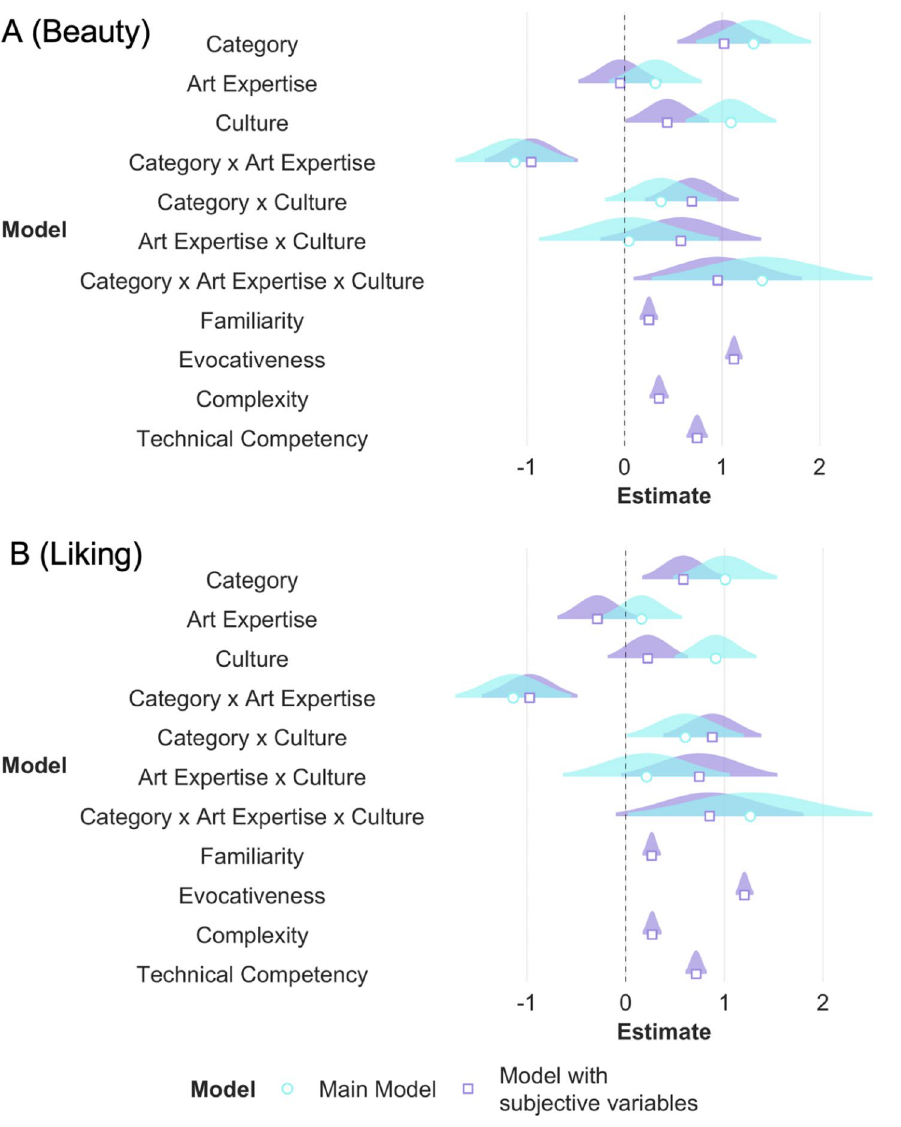
Figure 6. For the outcome variables of beauty ( A ) and liking ( B ), beta estimates for the main model (in aqua blue) and the model with subjective variables (in purple) are plotted for each predictor variable along with their corresponding uncertainties (95% confidence interval width for a normal distribution for each estimate). Distributions are rescaled to match the height of each distribution. This figure (and other similar figures) is made using the plot_summs function in the jtools R package (v. 2.1.0; Long,